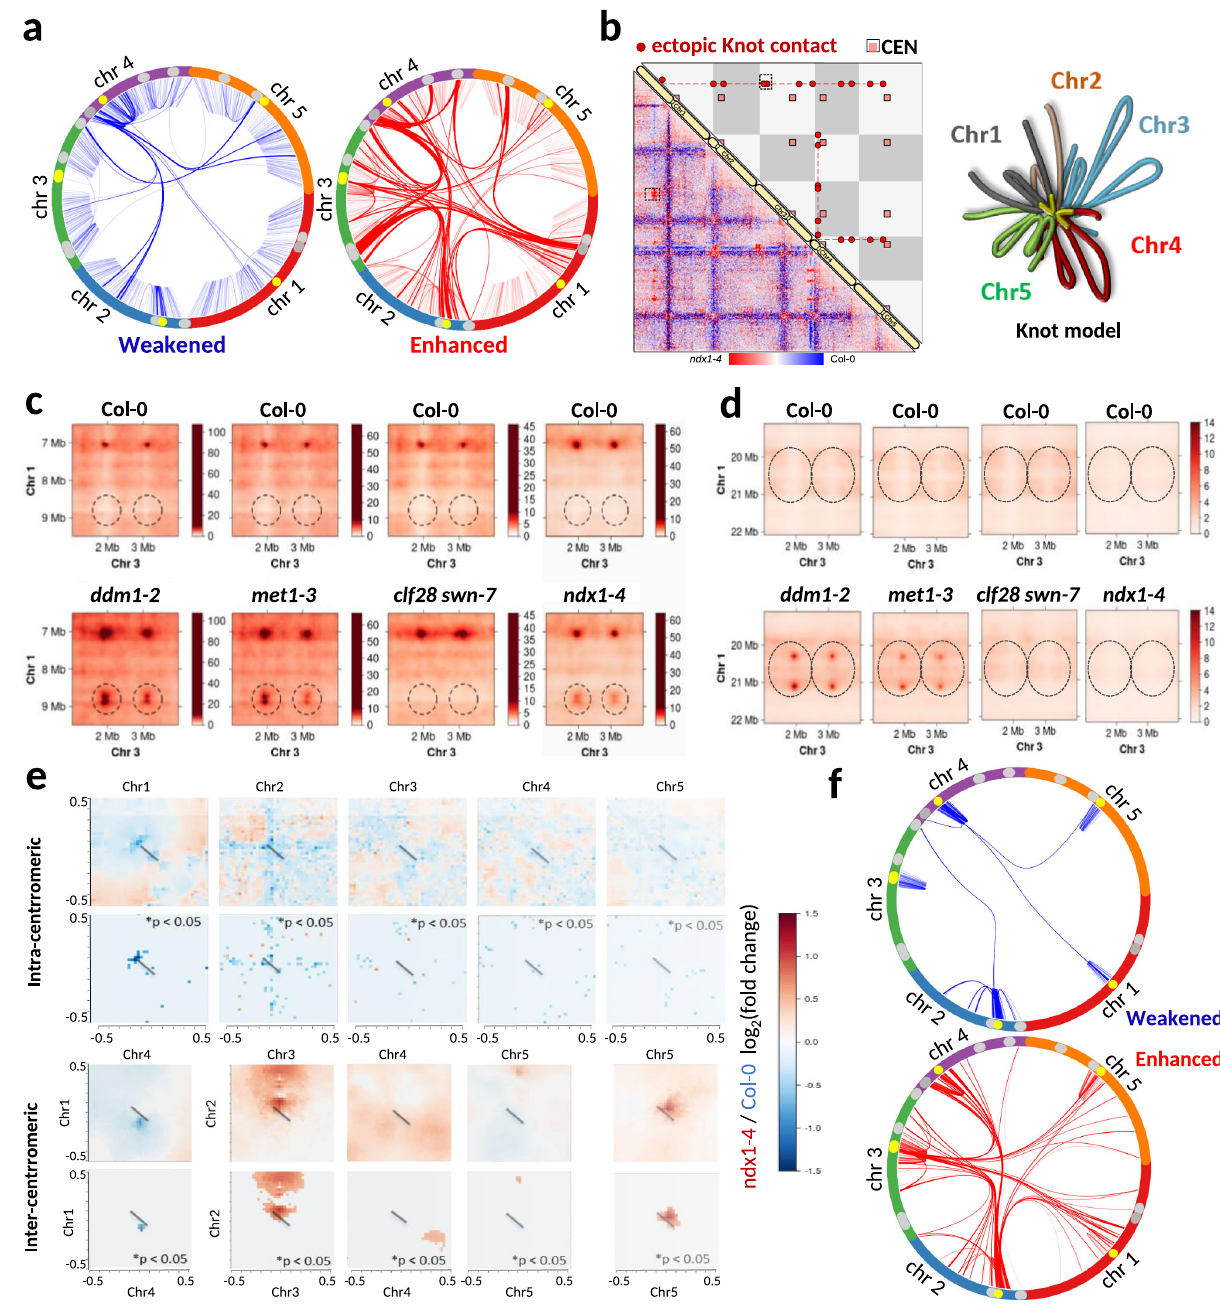
ndx1 – 4 mutants.Panel cshows denovo formedKnot contacts inthe ddm1-2 , met1- 3 , and ndx1 – 4 mutants thatare missing from Col-0 and clf28 swn7 . Paneld showsa ddm1-2 and met1-3 speci fi c Knot contact that is missing from ndx1 – 4 . e Pericentromeric chromatin shows local decompaction and enhanced inter- chromosomal interactions in the absence of NDX. Upper: Differential intra- centromeric Hi-C interactions represented by a pileup plot. Red and blue colors showenrichmentordepletionofintrachromosomalinteractionsofcentromeresin the ndx1 – 4 mutant.Diagonalbarsshowtheexactlocationsofcentromericregions. Signi fi cantly different regions are shown below (identi fi ed by Slitherine; permuta- tion test; p-value adjustment: Benjamini & Hochberg (FDR) method). Lower: The same as above but differential inter-centromeric interactions are shown. f Circos plot showing all intra- and interchromosomal interactions of centromeric regions that are signi fi cantly weakened or enhanced in the ndx1 – 4 mutant ( p <0.05, Sli- therinepipeline).ColorintensityofthearcsisproportionaltothefoldchangeinHi- C interactions ( ndx1 – 4 /Col-0). Outer circle represents the chromosomes. Cen- tromeres are highlighted in